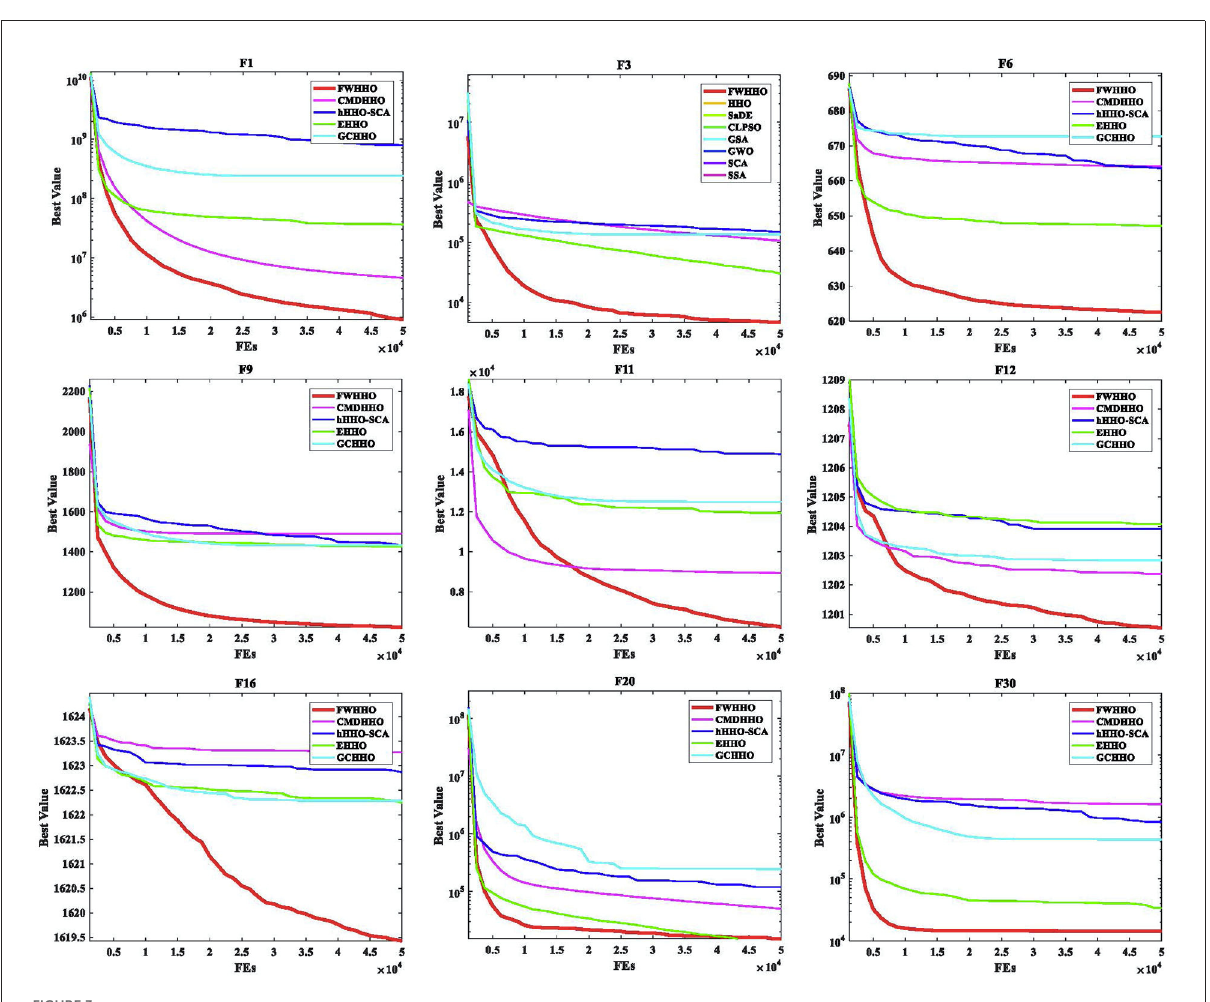
FIGURE3 Convergence curves of FWHHO and existing FWA